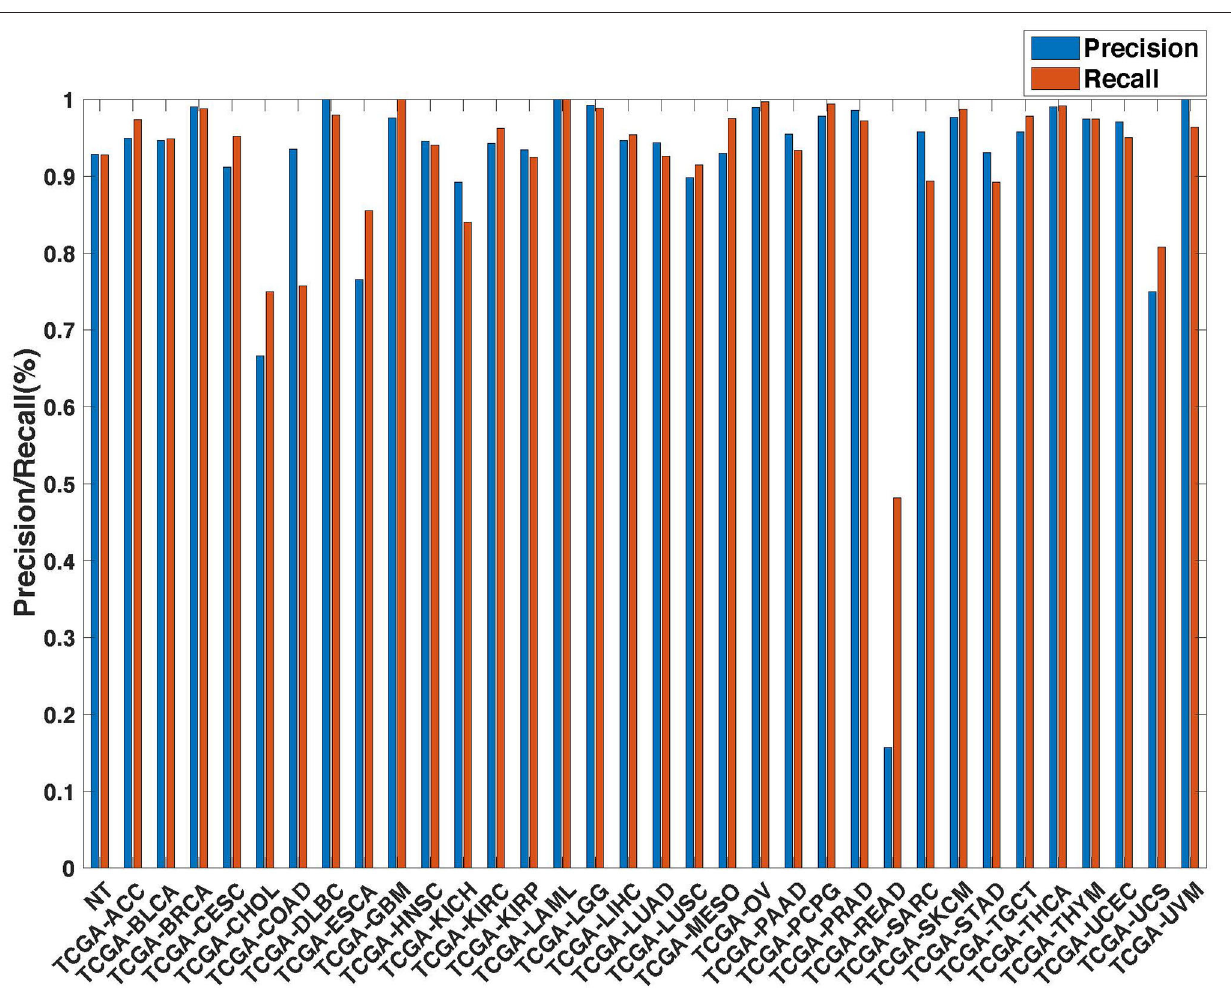
FIGURE 6 | Precision (blue) and recall (red) of the co-expression + singleton GCNN models trained with combined 33 different cancer types and normal